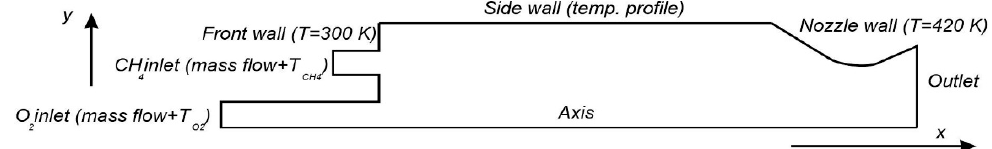
Figure 1. Schematic of the numerical domain (not drawn to scale).